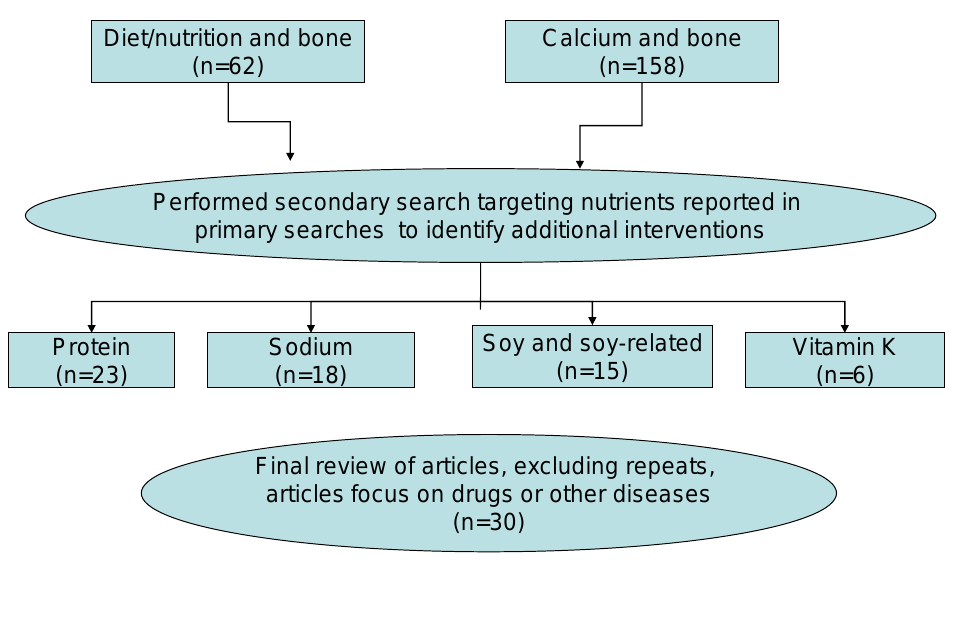
Figure 1. Description of methods for systematic